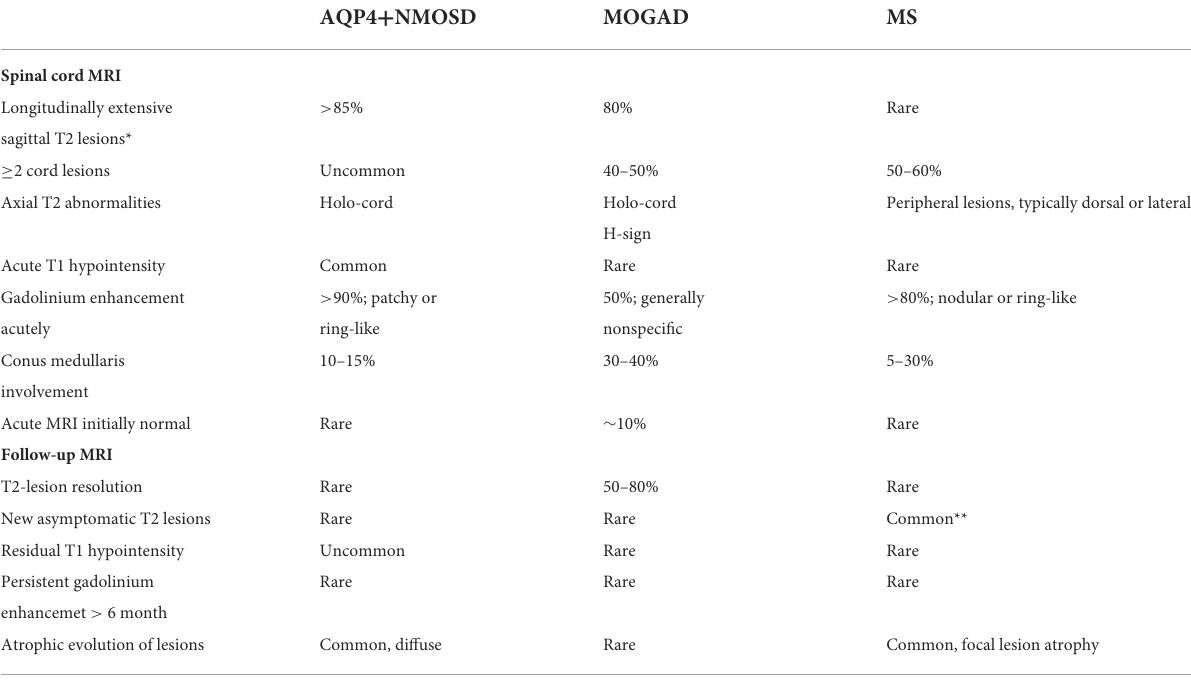
TABLE 2 Spinal cord MRI abnormalities in patients with AQP4-IgG-positive neuromyelitis optica spectrum disorders (AQP4 + NMOSD), MOG-IgG-associated disease (MOGAD), and multiple sclerosis